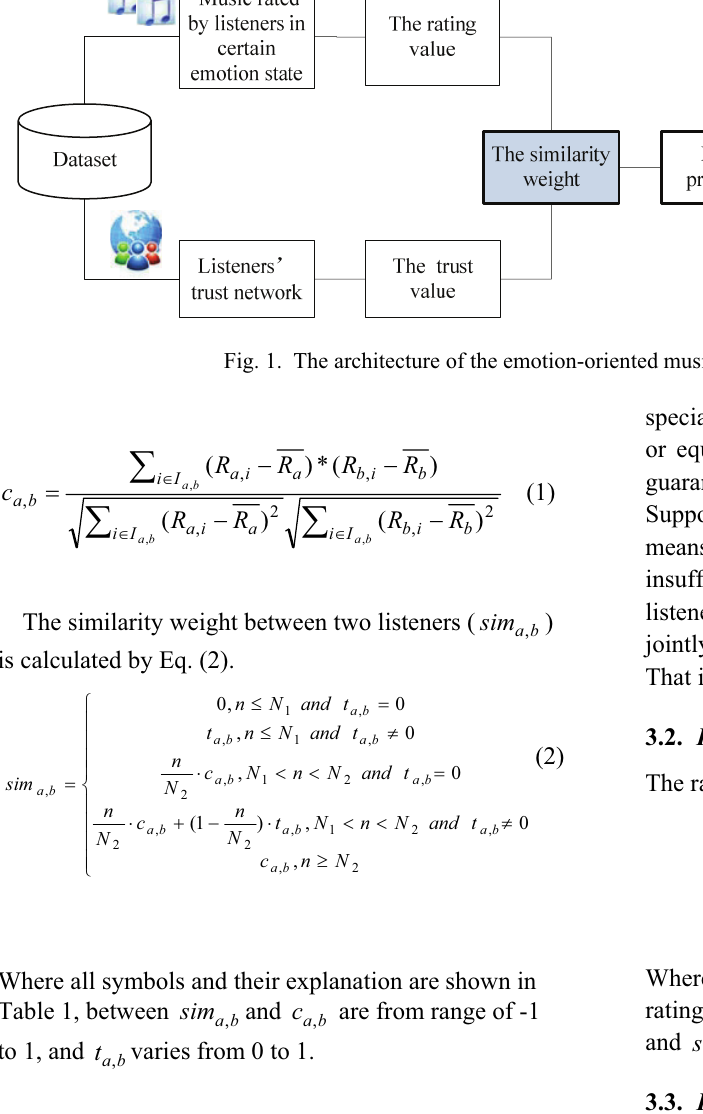
Table 1. Explanation of symbols.